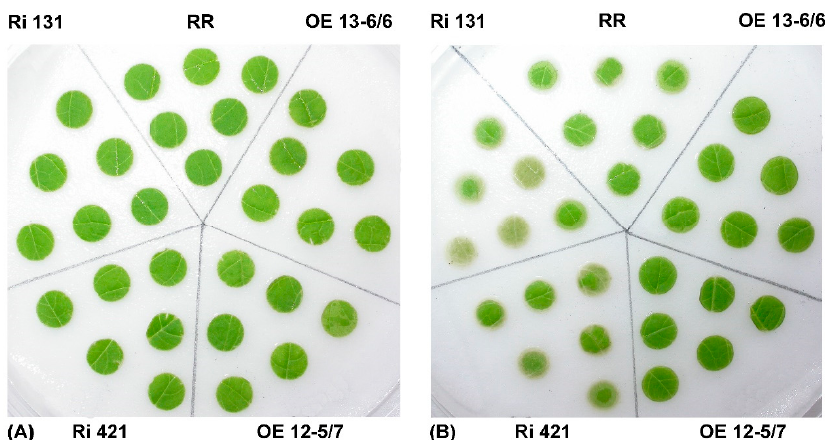
Figure 1. Effect of sulfite application on wild type and SO modified tomato lines. Leaf discs of wild type (RR), SO OE lines (OE 13-6 / 6, OE 12-5 / 7) and SO Ri lines (Ri 421, Ri 131) were subjected to ( A ) 0 mM and ( B ) 7 mM Na 2 SO 3 and photographed 24 h after starting the treatment.